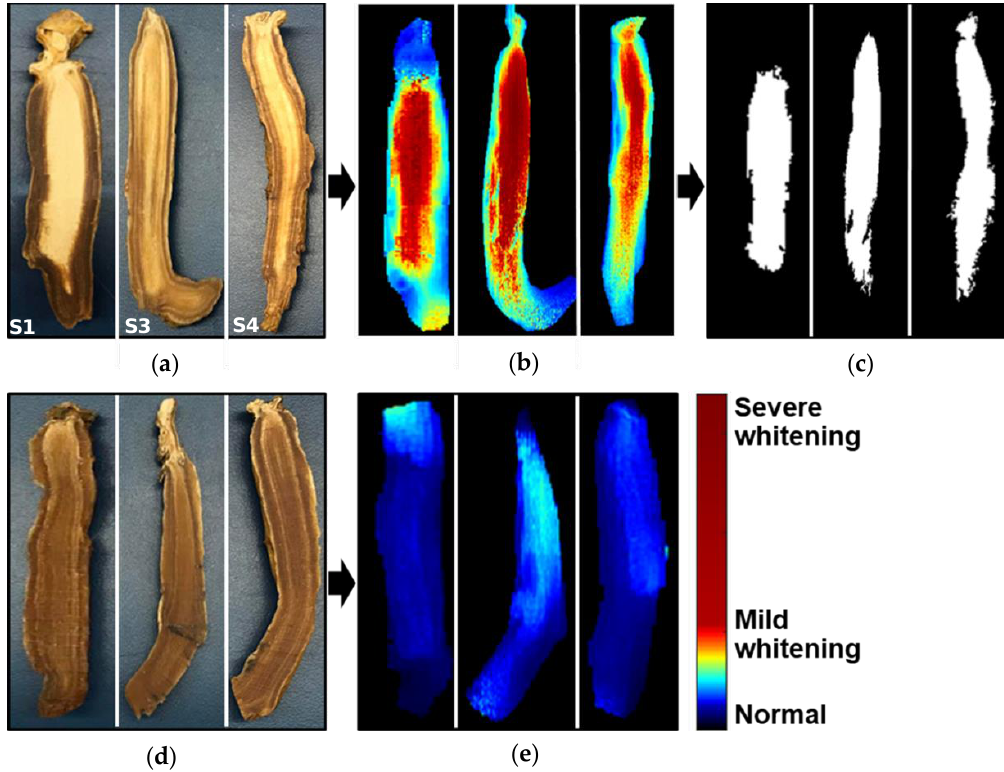
Figure 6. ( a ) RGB images of sliced abnormal ginseng samples (S1: 48.18% whitening, S3: 53.14% whitening, and S4: 37.66% whitening); ( b ) ratio image visualizing the whitening region (red pixels) in abnormal ginseng samples; ( c ) binary image of detected whitening region in abnormal ginseng samples; ( d ) RGB images of sliced normal ginseng samples. ( e ) Ratio images of normal ginseng samples. Coloration map has been added to the ginseng and the whitened region, to enhance visual discrimination.